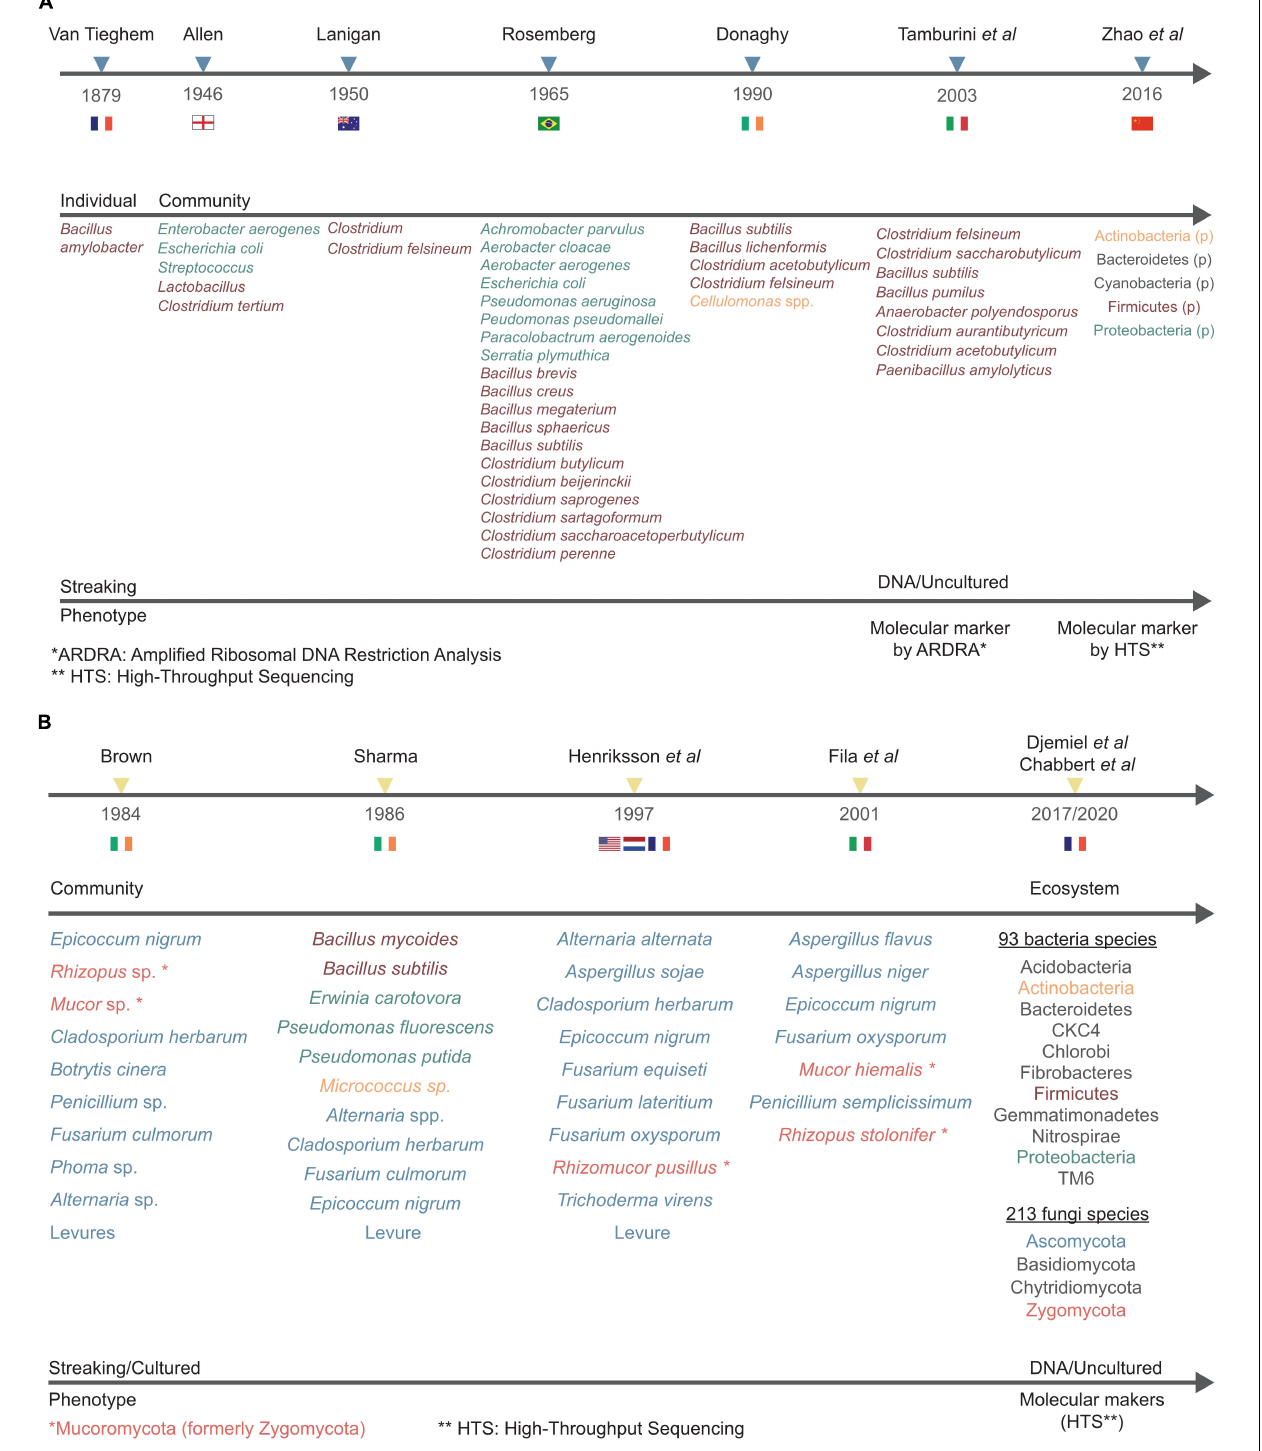
FIGURE 3 | Timelines showing the increasing number of bacterial and fungal species identified over time in flax water-retting (A) and dew-retting (B) . Figure shows authors and year of published studies ( top line), microbial organization level (individual, community, ecosystem) and name ( middle line), culture method and type of analysis ( bottom line). The color of phyla (HTS approach) and species names indicates the identification method type (classical vs . HTS). When phyla names are in black it means that they have been identified for the first time by metabarcoding approaches.